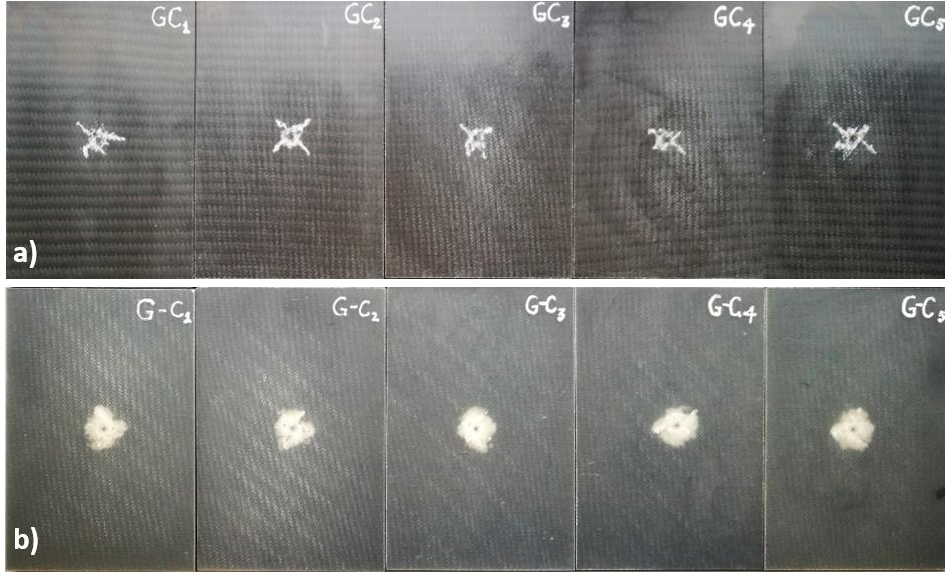
Figure 6. Front impacted side of inter-hybrid configurations ( a ) GC and ( b ) G-C, post-impact dam- aged specimens.